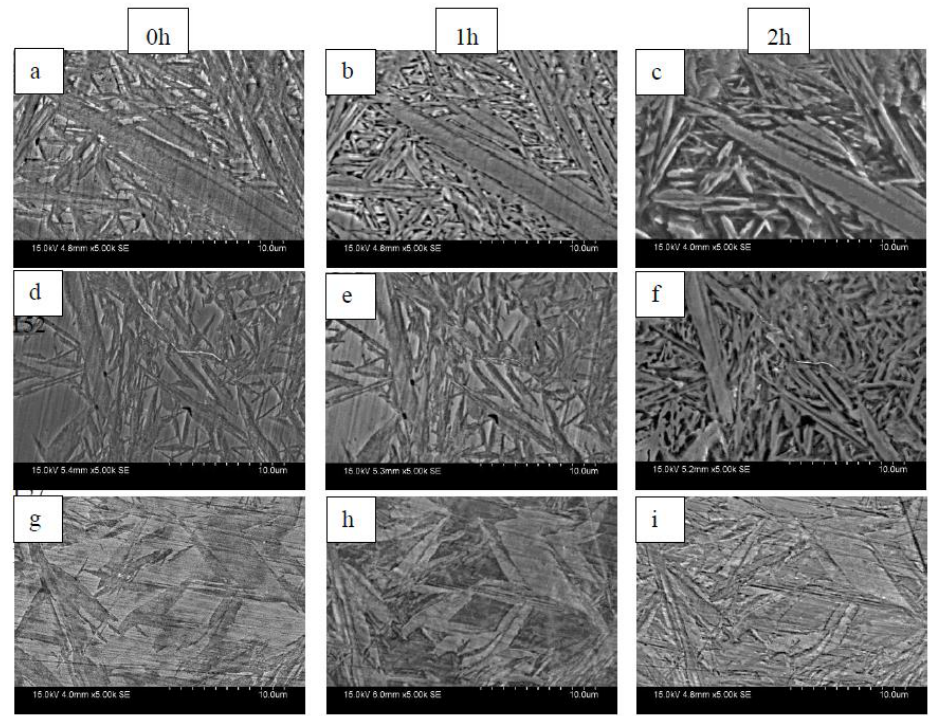
Figure 1. SEM images of different percentage of Cr, in which ( a – c ) with 0.10 – 0.18% Cr; ( d – f ) with 0.60 – 0.80% Cr; and ( g – i ) with 1.80 – 2.50% Cr. All samples were etched at t = 0 h. 0.60–0.80% Cr; and ( g – i ) with 1.80–2.50% Cr. All samples were etched at t = 0